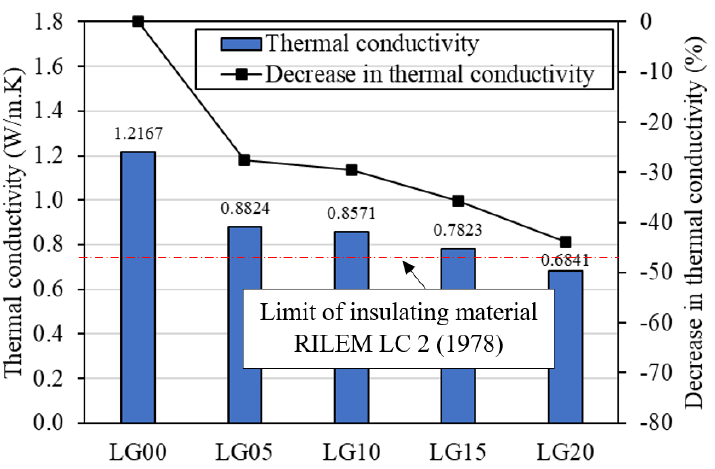
Figure 12. Thermal conductivity of geopolymer mortar containing BLWA compared with the limit of insulating material as RILEM LC 2 [74].